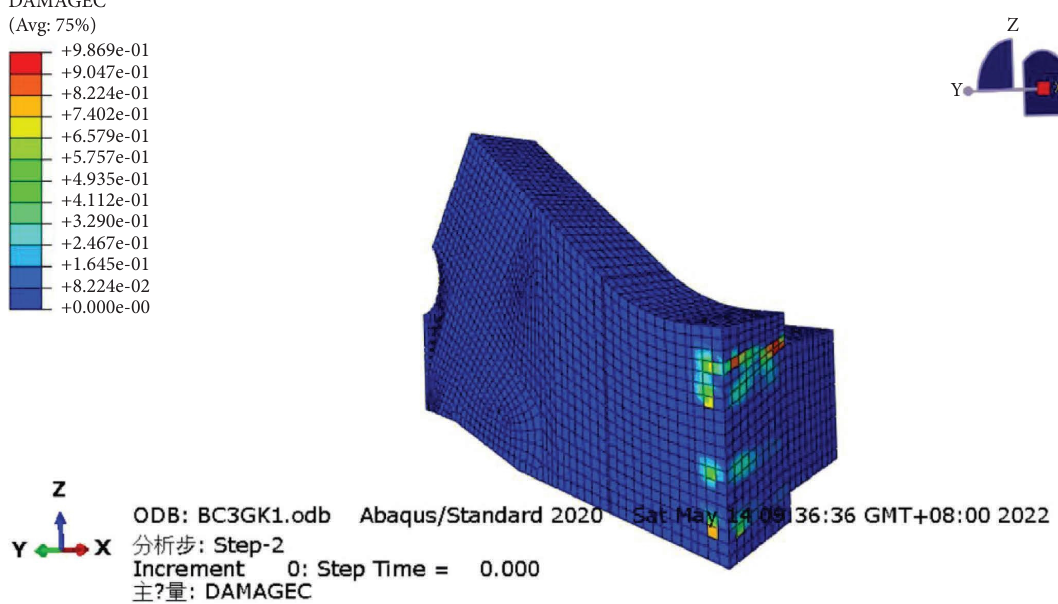
Figure 8: Cloud chart of concrete compression plastic damage of condition